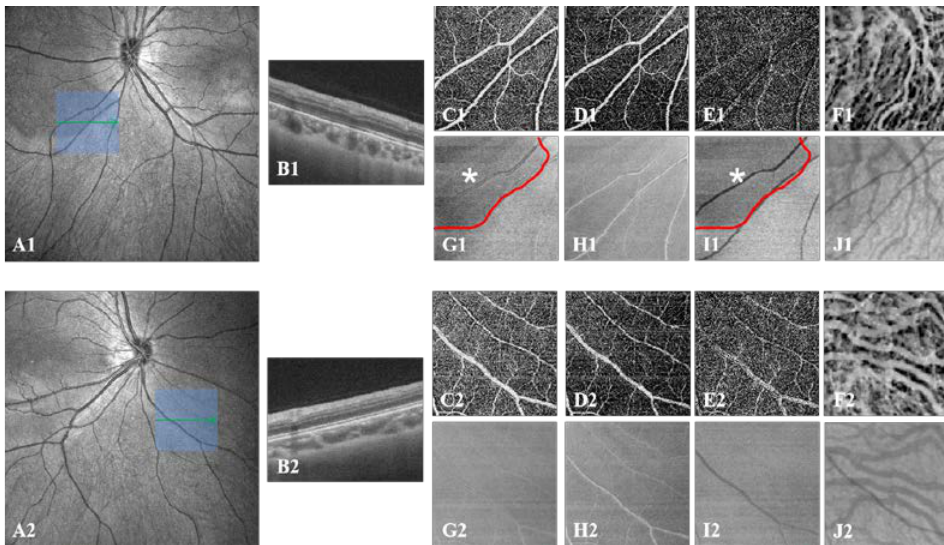
Figure 4. SS-OCT/OCTA images of local lesion areas and corresponding normal areas in both eyes. ( A1 – J1 ) Images of one eye with a DWOP lesion. ( A1 ) SS-OCT en-face image of the left eye, revealing the location (blue cube) from which all subsequent images ( C1 – J1 ) were taken and the single scan (green arrow) which corresponds to the OCT B-scan ( B1 ); ( C1 – F1 ) SS-OCTA vascular en-face images of the inner retina, SVC, DVC, and choroid; ( G1 – J1 ) SS-OCT thickness en-face images of all retina layers, inner retina, outer retina, and choroid. DWOP lesion (shown as a red curve) in ( G1 ) and ( I1 ) (white *). ( A2 – J2 ) Images of the comparison eye without a DWOP lesion. ( A2 ) SS-OCT en-face image of the right eye, revealing the location (blue cube) from which all subsequent images ( C2 – J2 ) were taken, and the single scan (green arrow), which corresponds to the OCT B-scan ( B2 ); ( C2 – F2 ) SS-OCTA vascular en-face images of the inner retina, SVC, DVC, and choroid; ( G2 – J2 ) SS-OCT thickness en-face images of all retina layers, inner retina, outer retina, and choroid, which appear to be normal. DWOP, dark without pressure; SS-OCTA, swept-source optical coherence tomography angiography; OCT, optical coherence tomography; SVC, superficial vascular complex; DVC, deep vascular complex.